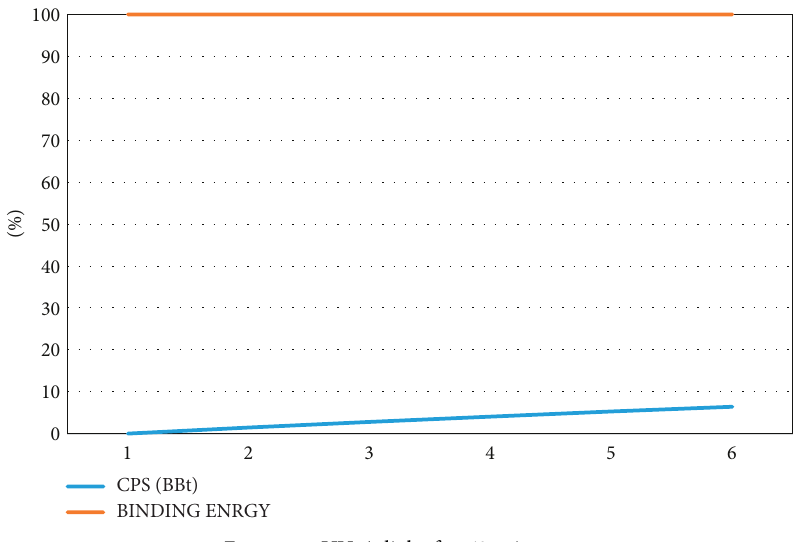
Figure 5: UV-A light for 60 minutes.